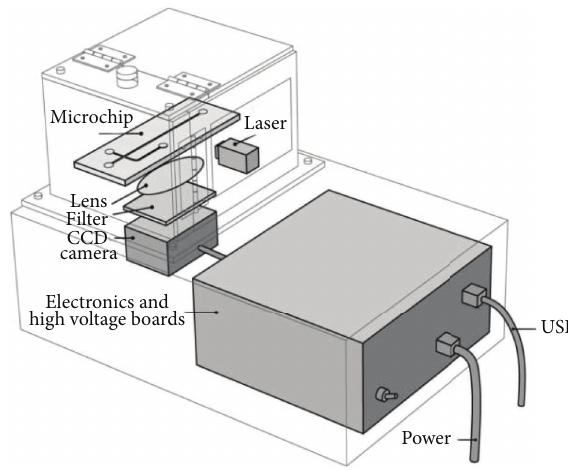
Figure 1: Integrated genetic analysis platform comprising the PCR- LOC device and the control electronics. The platform is operated through a graphical user interface